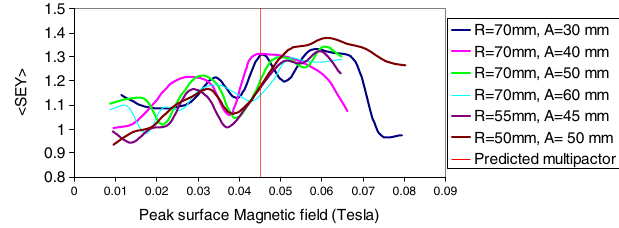
FIG. 16. Maximum h SEY i as a function of peak surface mag- netic field from CST PARTICLE STUDIO for various 800 MHz cavity geometries. The iris radius, R , and the iris rounding, A , are given for each geometry. The red line shows the predicted onset of